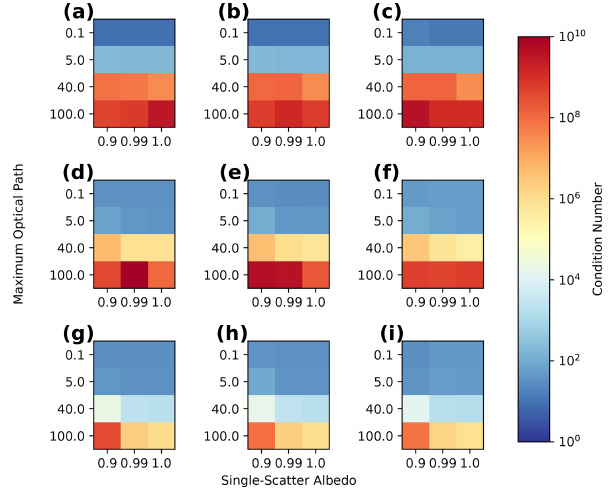
Figure 13. The condition number (see text for details) of the ap- proximate Jacobian for 3D Gaussian clouds with different combina- tions of single-scattering albedo and maximum optical path. Same as Fig. 5 but for the approximate Jacobian. Panels (a) , (b) , and (c) have isotropic phase functions. Panels (d) , (e) , and (f) have Mie phase functions, and panels (g) , (h) , and (i) have Mie phase func- tions with a reduced angular resolution (see text for details). Pan- els (a) , (d) , and (g) have a black surface. Panels (b) , (e) , and (h) have Lambertian surface albedos of 0.2, while panels (c) , (f) , and (i) have Lambertian surface albedos of